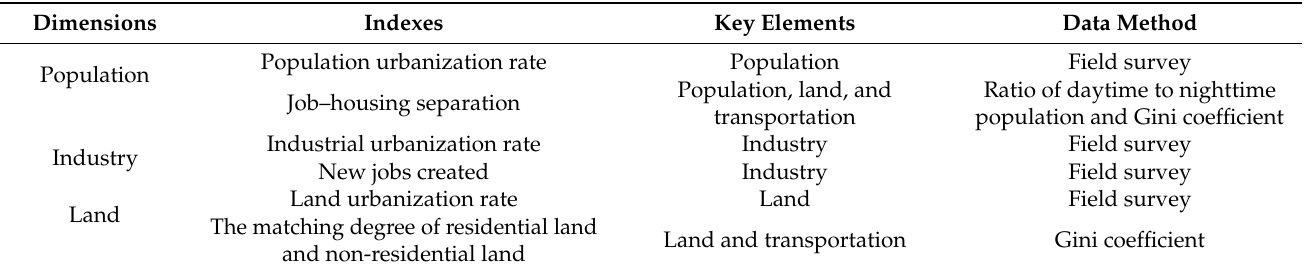
Table 2. The dimensions, key elements, and index system for evaluating the level of development of city–industry integration at the city